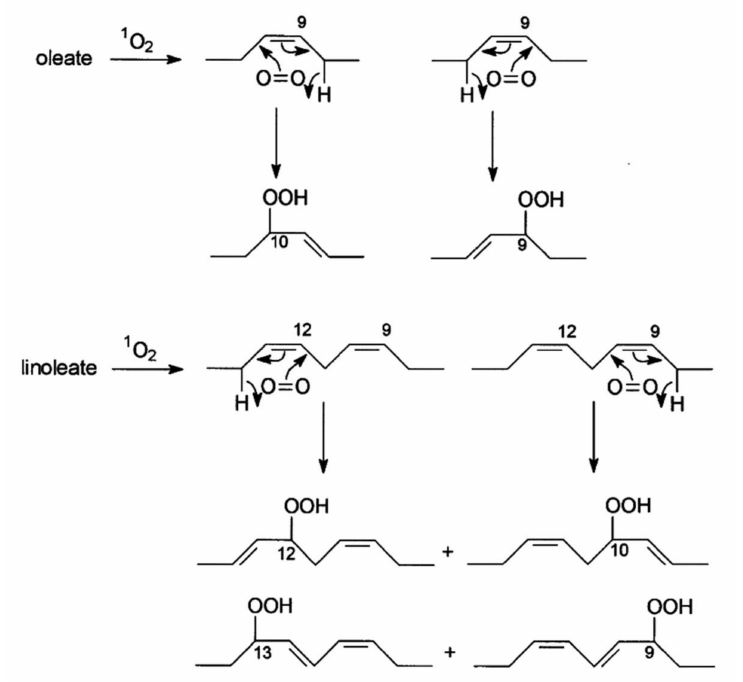
Figure 3. Oxidation of oleate and linoleate by singlet oxygen. Adopted with permission from [11]. Copyright 2005, Elsevier Science; Woodhead Publishing.